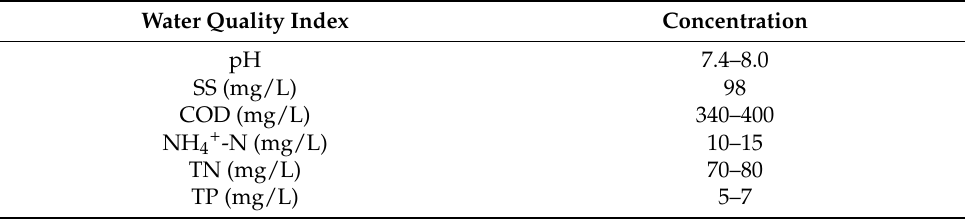
Table 2. The water quality parameters of the synthetic wastewater.